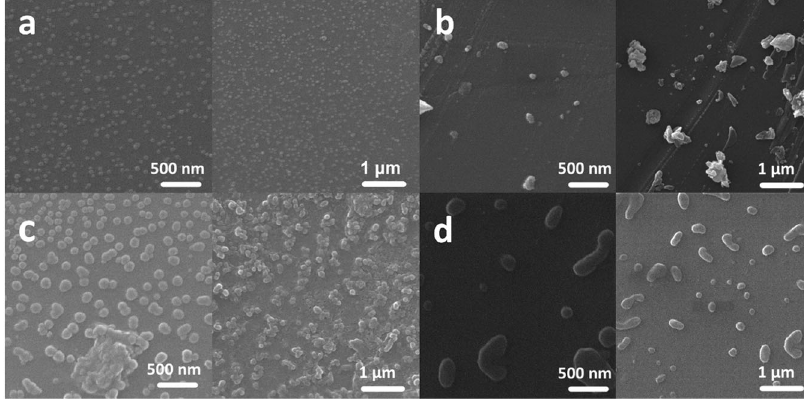
Fig. 5 SEM morphological characterization of Hydrogels. a CS-g-gly, ( b ) VCR/CS-g-gly, ( c ) CMCS-g-gly, ( d )